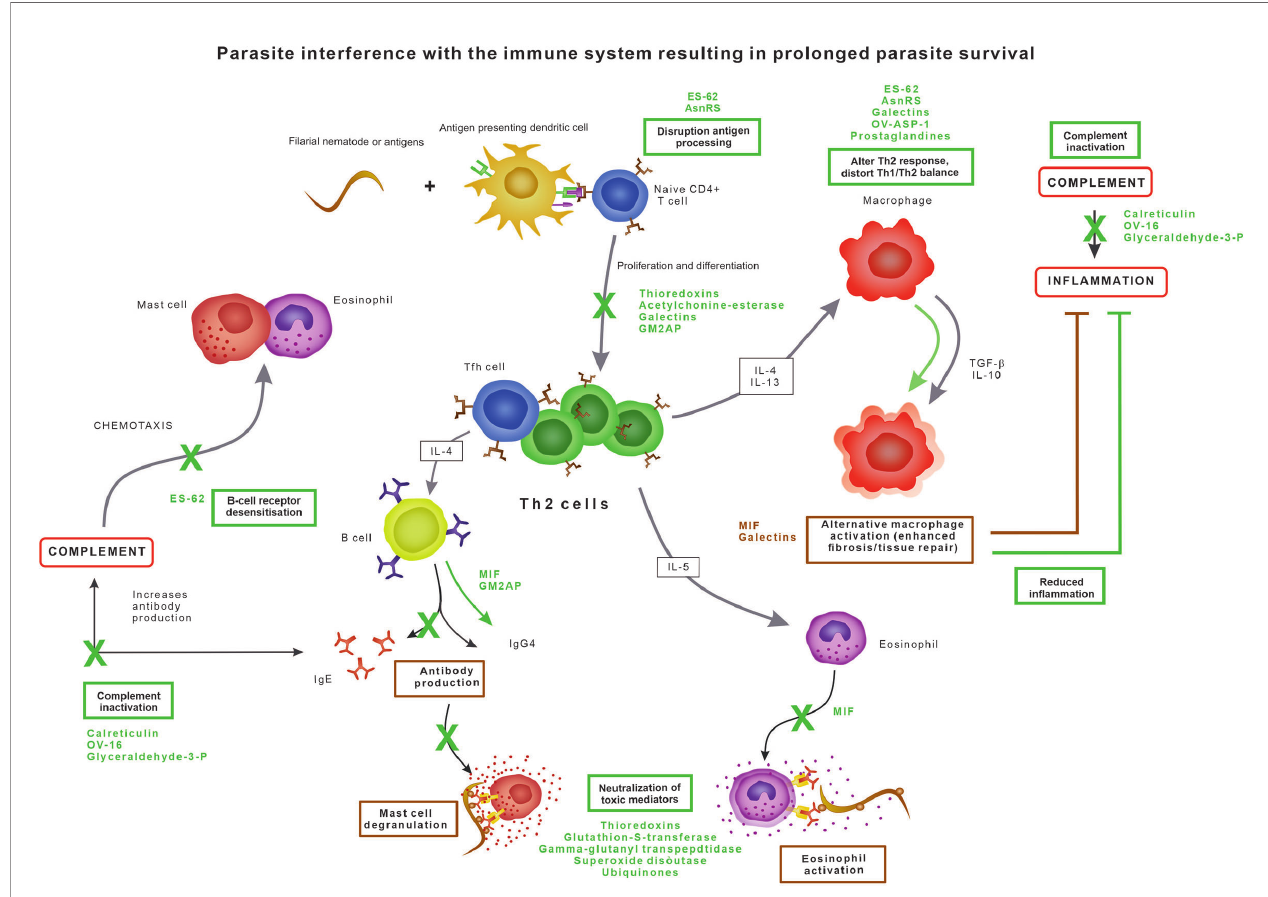
FIGURE 1 | Parasite evasion strategies interfering with the normal immune response, resulting in prolonged parasite